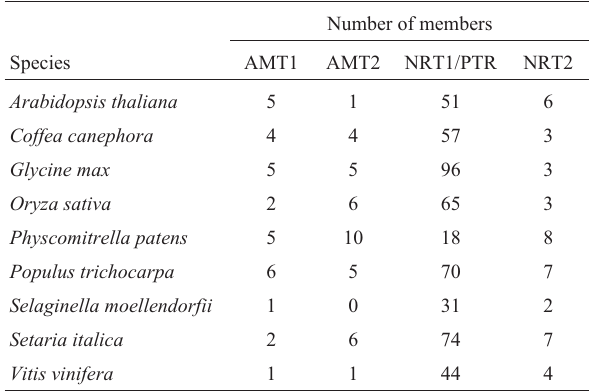
Table2 -Comparisonofmembersfromthe AMT1 , AMT2 , NRT1 /PTRand NRT2 gene families in Viridiplantae, based in von Wittgenstein et al. (2014) and Pii et al.